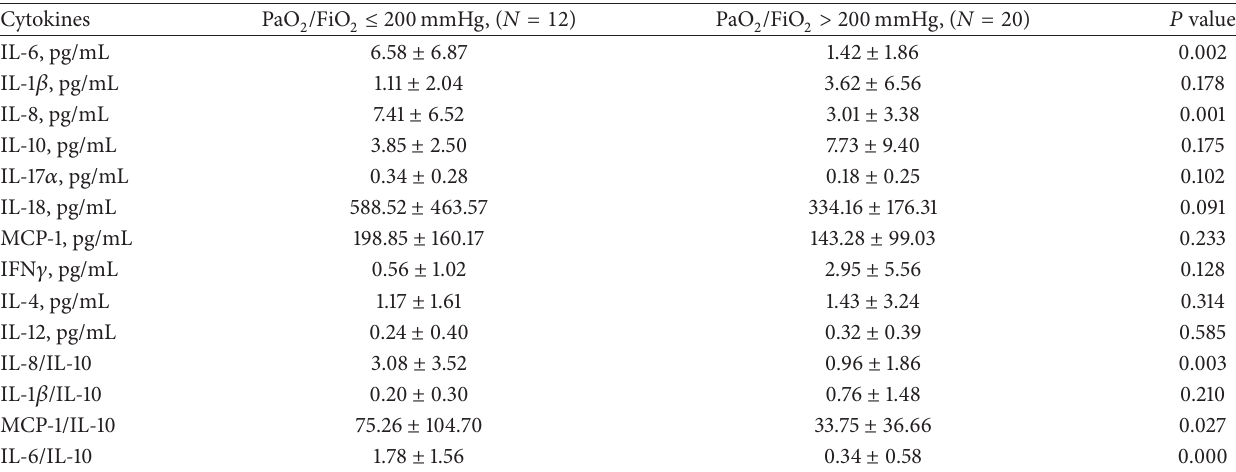
Table 3: Comparisons of cytokines between PaO 2 /FiO 2 ≤ 200 and > 200 mmHg.